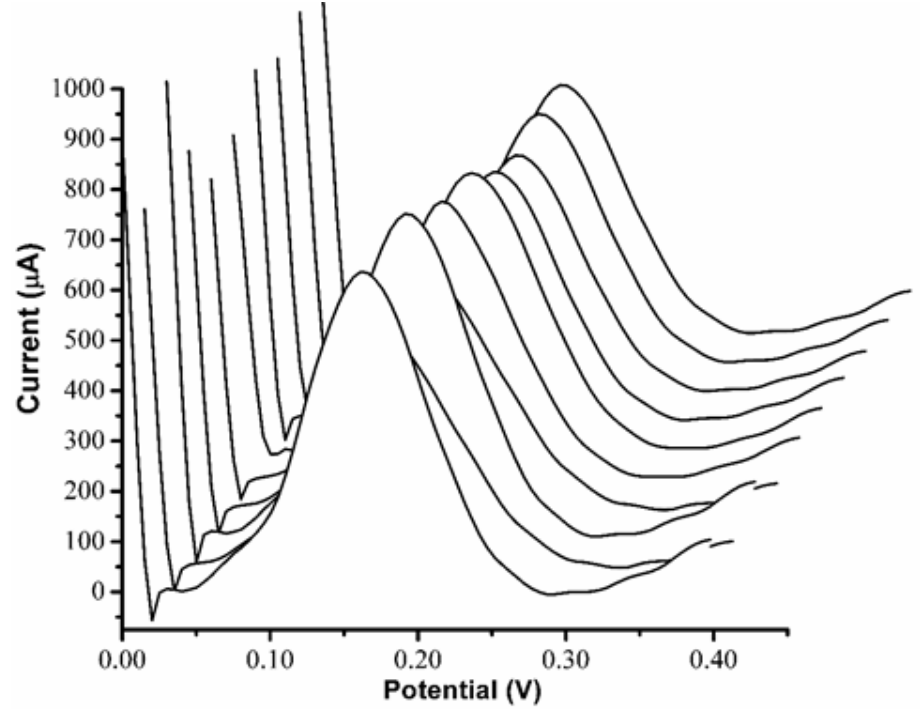
Figure 7. Repeatability study of the MIP PGE sensor. The response of the sensor electrode was for 5.27 nM DA. The measurements were repeated 10 times ( n = 10).